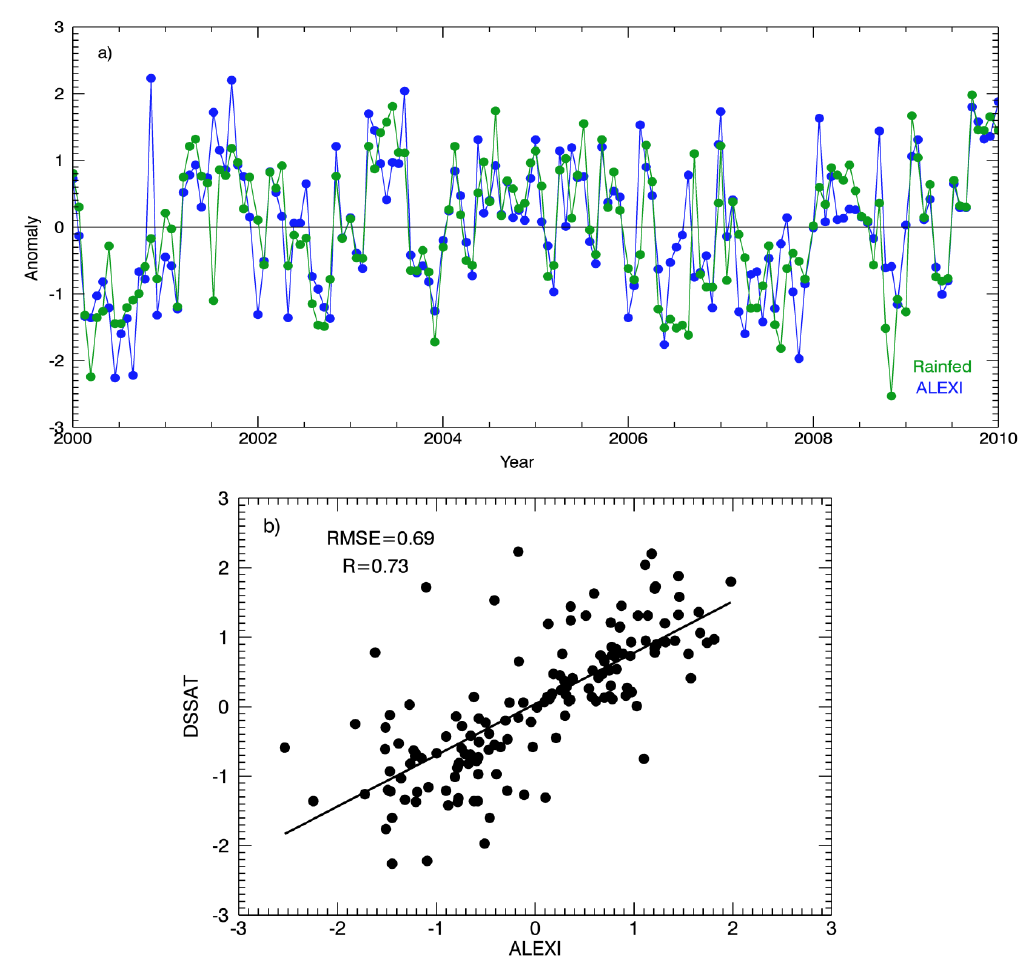
Figure 2. ( a ) Anomaly time series between DSSAT rainfed (green) and ALEXI (blue) 14-day soil moisture composite at Belle Mina, Alabama for the period of 2000–2010; ( b ) Scatter plot of the anomalies between DSSAT and ALEXI again at the Belle Mina, Alabama.